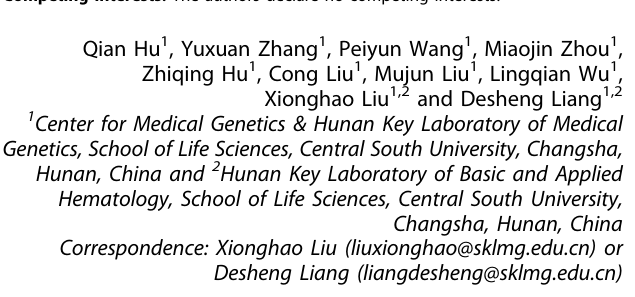
Fig. 1 Enhanced antitumor activity and persistence of CAR19-IL-24-T cells. a Schematic diagram of FMC63scFv-28 ζ (CAR19) and CAR19-IL-24. SP, signal peptide; 2A, 2A “ self-cleaving ” peptide; EGFP, enhanced green fl uorescent protein. b Representative fl ow cytometry data showed